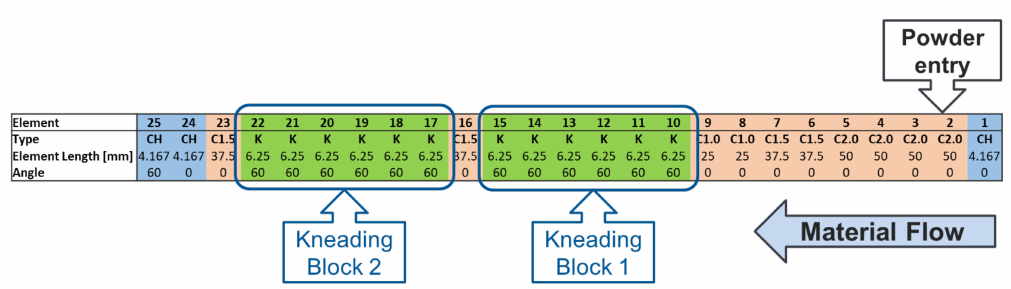
Figure 3. Typical experimental screw configuration, as used in the full-scale DEM simulations. CH represents a chopping element, C1.5 represents a conveying element of length 1.5 times the screw lead and K denotes a kneading